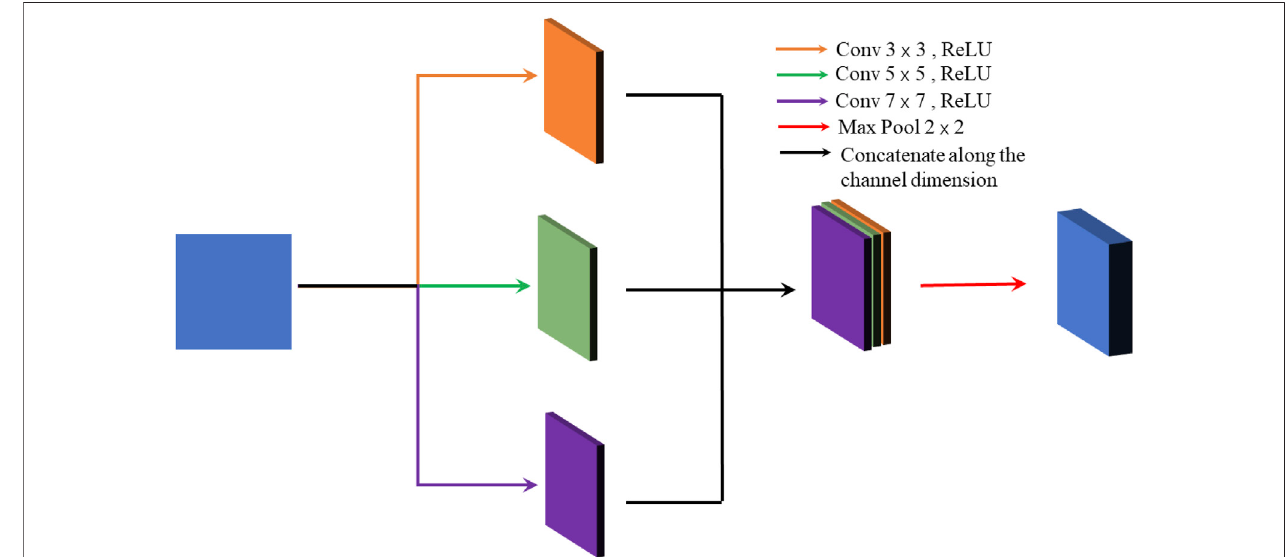
FIGURE 2 | Structure of multi-feature extraction layer.